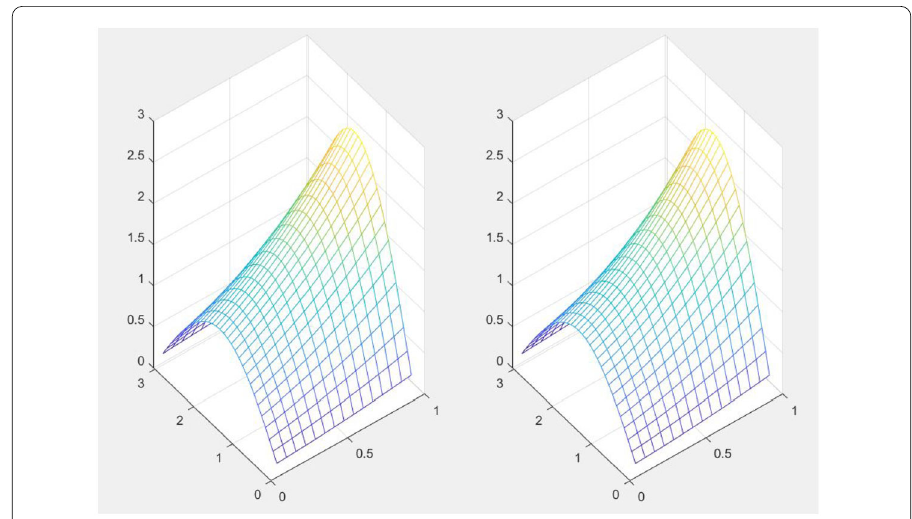
Figure 7 The 3D-plot of the analytical solution (left) and the numerical solution (right) for Example 7.4